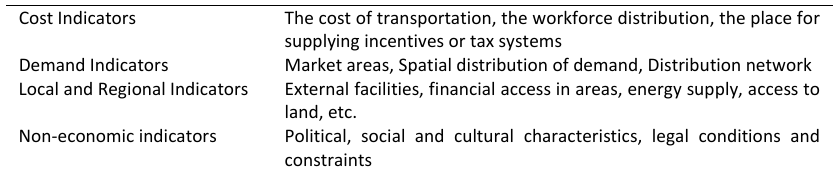
Table 1: Main site selection Indicators